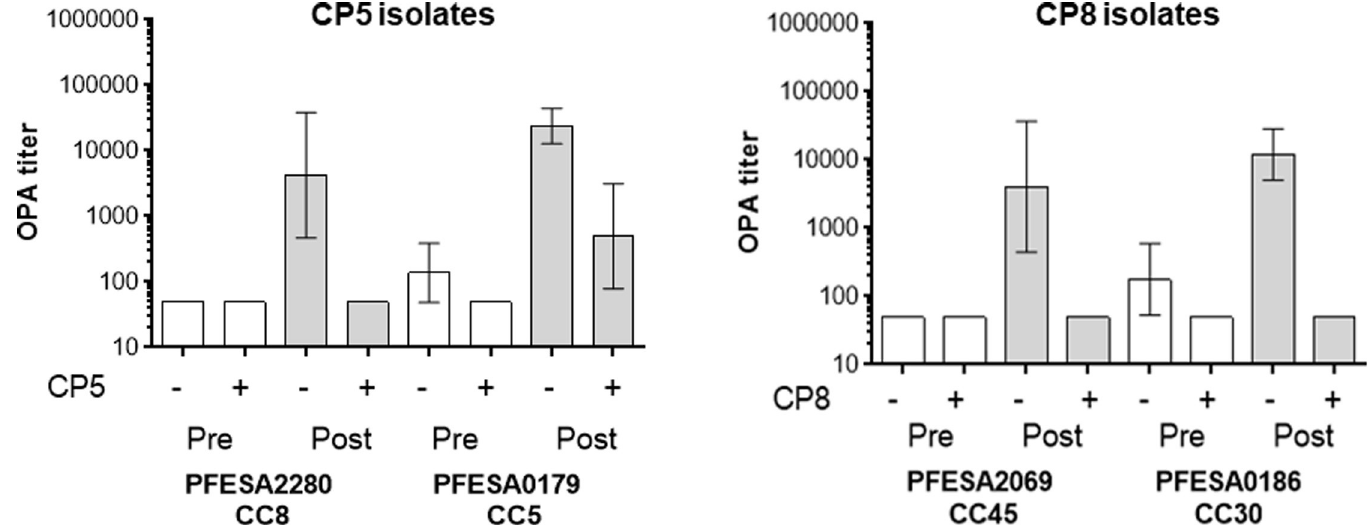
Fig 3. Killing of diverse S . aureus clinical isolates by human immune sera in CP5/CP8 OPA assays. Opsonophagocytic activity of clinical sera from ten vaccinated subjects (Pre: prevaccination bleed and Post: 29 days post vaccination bleed) were determined against CP5 and CP8 isolates representing the four most prevalent clonal complexes. Bars reflect geometric mean OPA titers from sera of ten immunized subjects tested in two separate experiments with 95% confidence intervals (error bars). CP specificity of the OPAs was demonstrated with anti-CP antibody depleted sera (CP5/8 +) generated as described in the Material and Methods section.